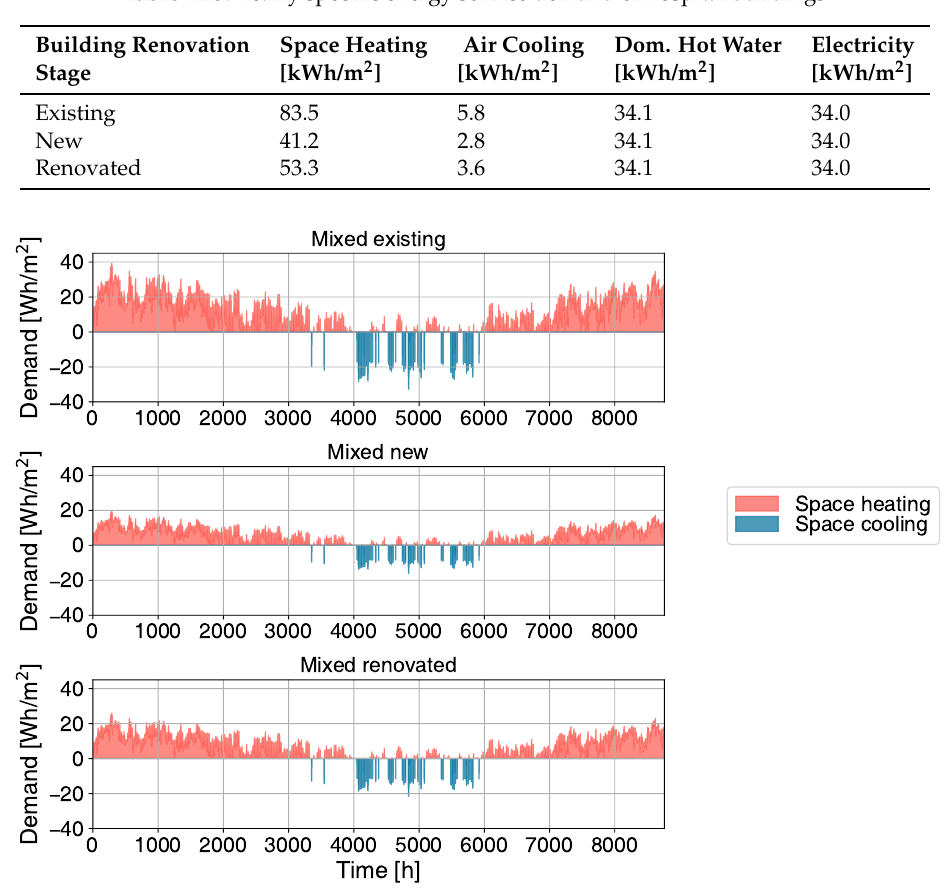
Table A23. Yearly specific energy service demand of hospital buildings.